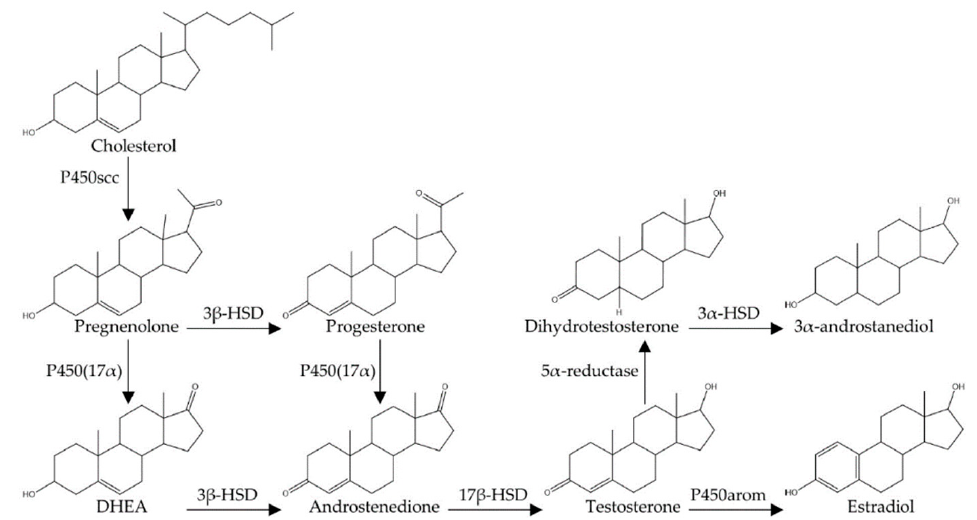
Figure 1. Key sex steroid synthesis pathways found in the gonads and the brain. Enzyme name abbreviations are as follows: P450 side-chain cleavage enzyme (P455scc), 17 α -hydroxylase [P450(17 α )], 3 β -hydroxysteroid dehydrogenase (3 β -HSD), 17 β -hydroxysteroid dehydrogenase (17 β - HSD), 3 α -hydroxysteroid dehydrogenase (3 α -HSD), and P450 aromatase (P450arom) [48,52,54].